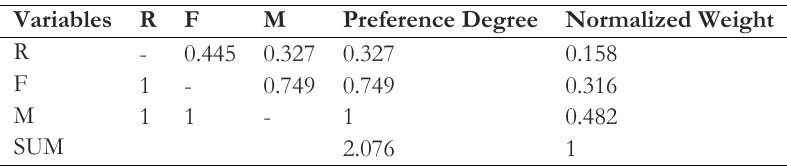
Table 4. Calculating preference degree and normalized